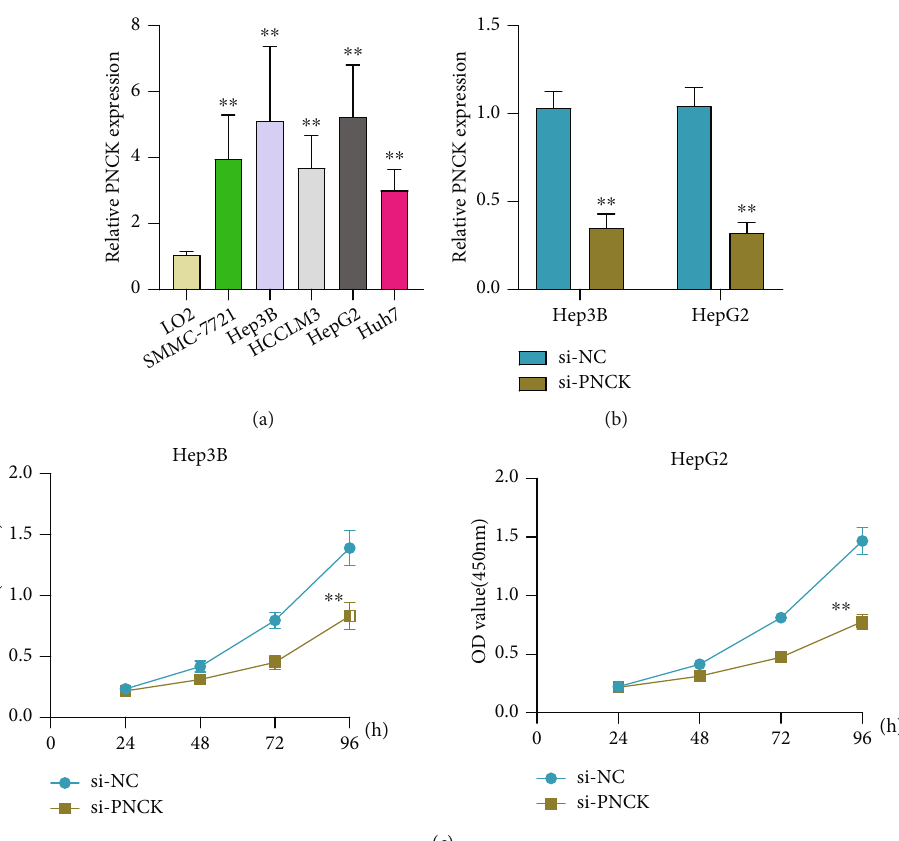
Figure 7: The oncogenic roles of PNCK in HCC progression. (a) RT-PCR was used to examine the expressions of PNCK in four HCC cells and LO2. (b) The expression of PNCK was distinctly decreased in HepG2 and Hep3B cells after the transfection of si-PNCK. (c) Proliferation of HepG2 and Hep3B cells with knockdown of PNCK by CCK-8 assay. ∗∗ P < 0 : 01